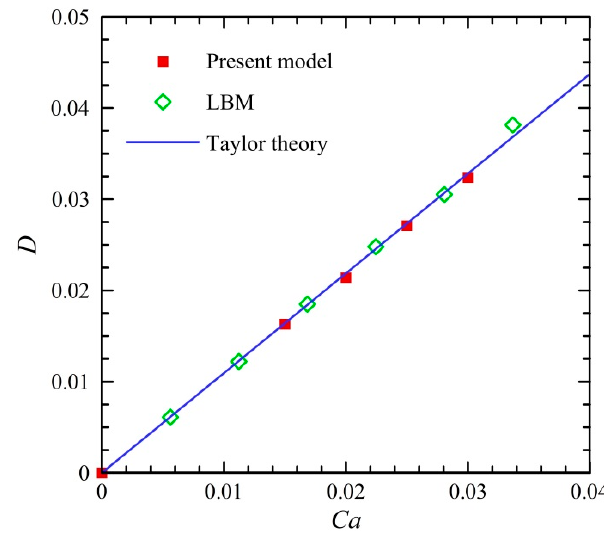
Figure 3. Droplet deformation in a simple shear flow.